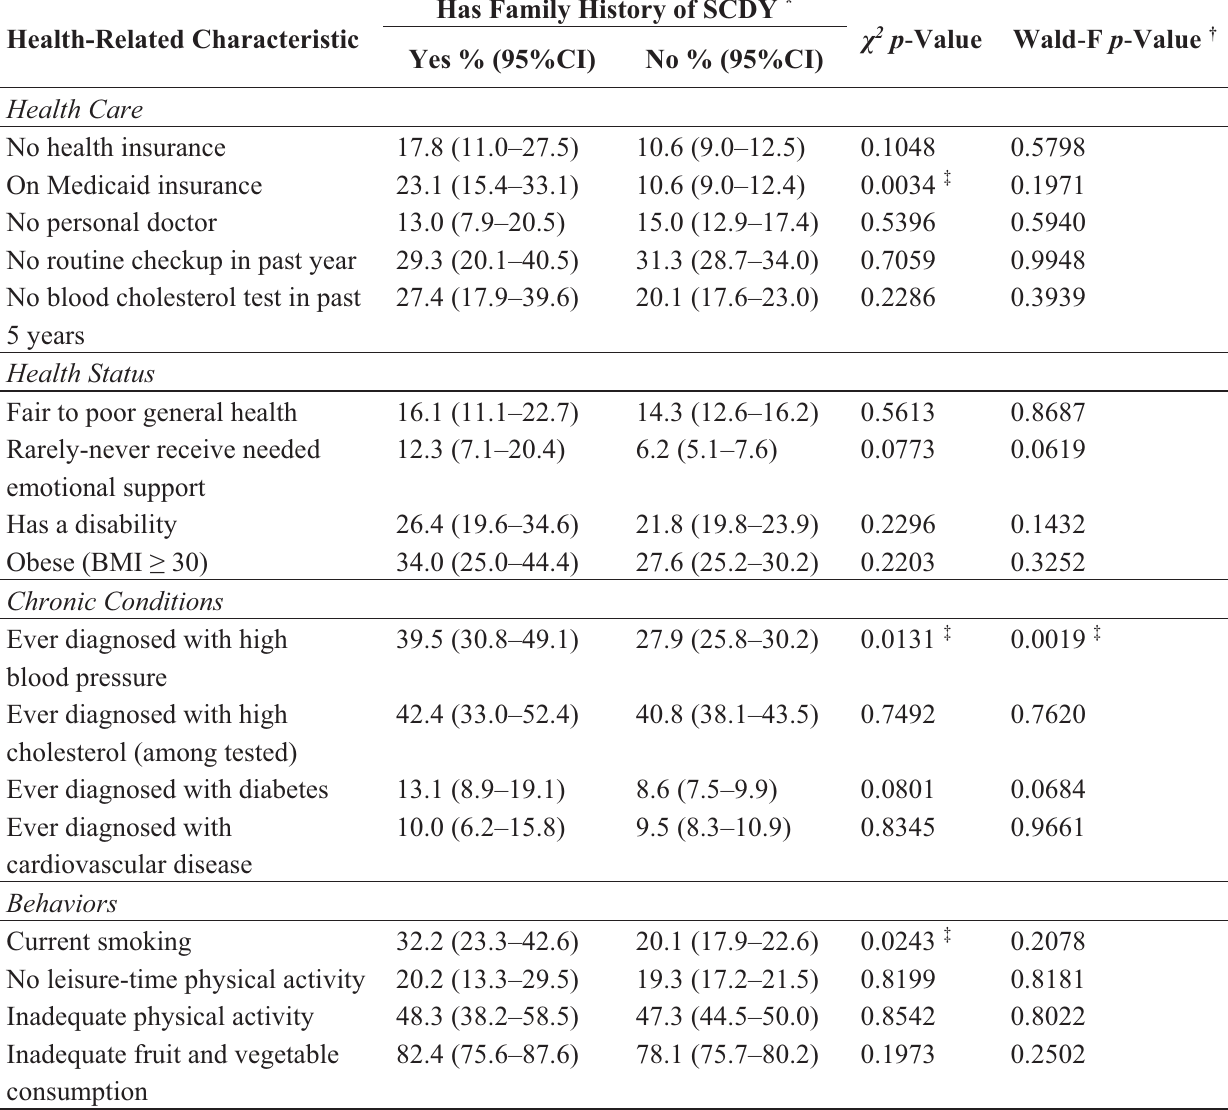
Table 4. Prevalence of health-related characteristics among Michigan adults by family history of sudden cardiac death of the young